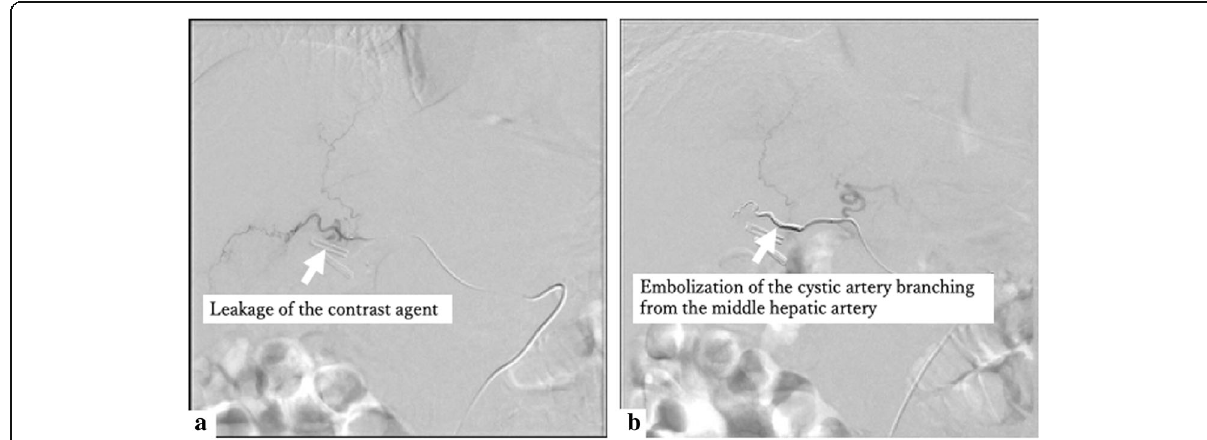
Fig. 4 Angiographic examination. a Angiographic examination selective for the cystic artery branching from the middle hepatic artery revealed leakage of the contrast agent into the remaining lumen of the gallbladder neck and a micro-pseudoaneurysm. b Embolization of the cystic artery branching from the middle hepatic